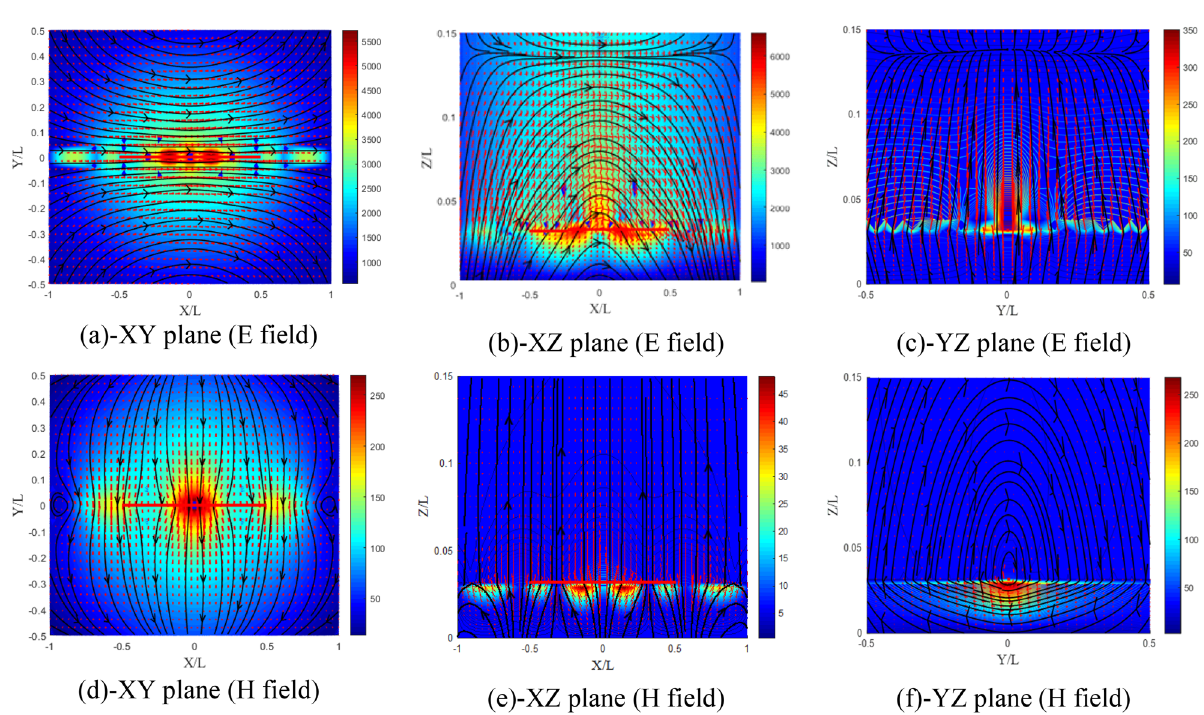
0.5 ) case, ( a – c ) electric and ς xy = =